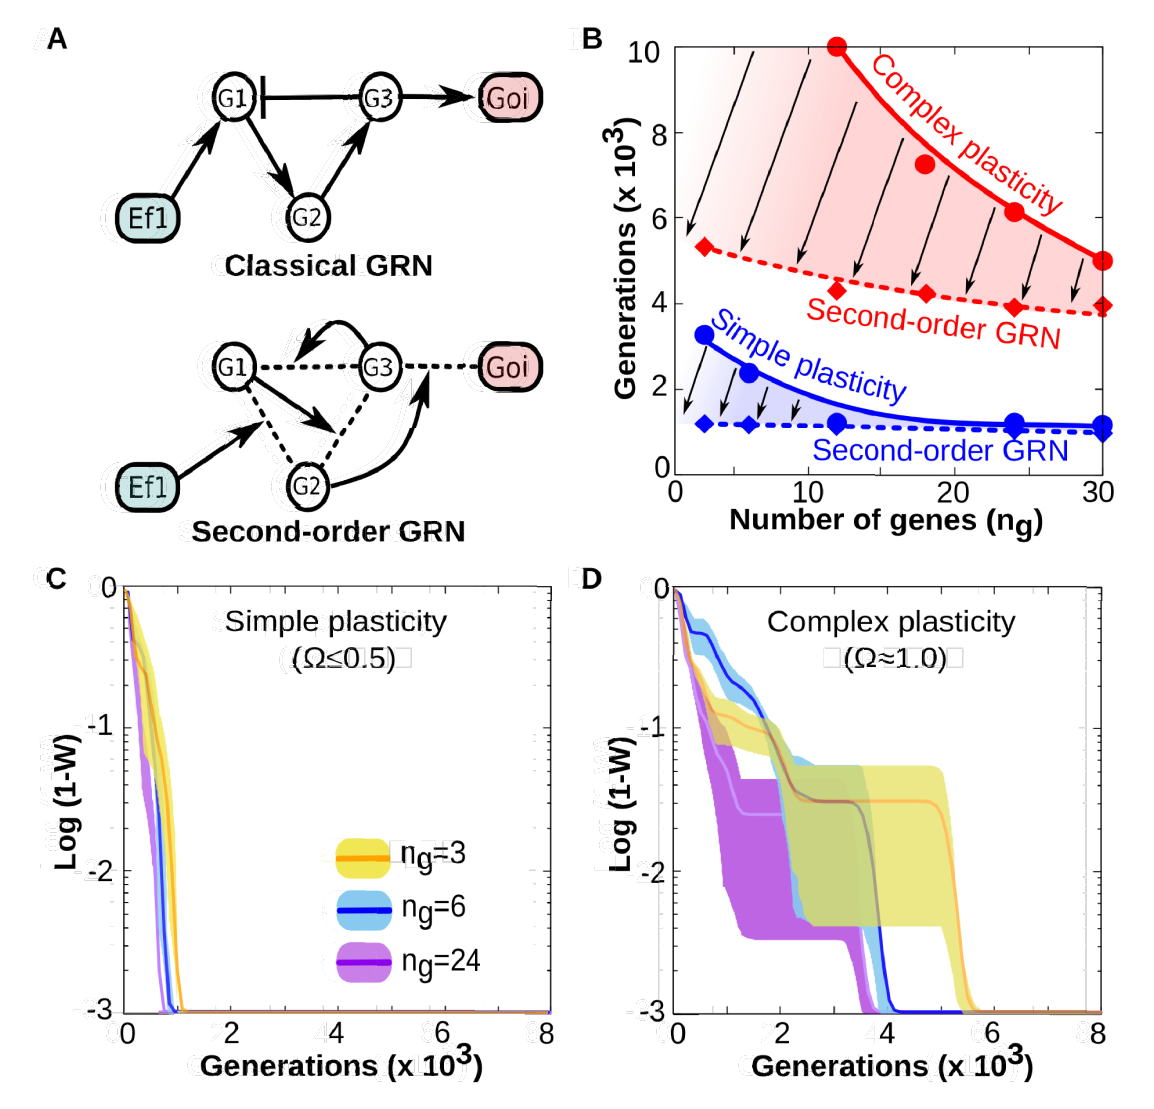
Fig 3. Second-order implementation of cell plasticity enhances evolvability. A) Contrary to “classical” GRNs in which the network topology remains fixed over developmental time, second -order (tensor-based) GRNs have dynamical topology: each gene-gene interaction strength is determined by the concentration of other genes ( g , g , etc) and environmental factors. In both cases the final phenotype is recorded as the binary 1 2 state of a gene of interest ( goi ). B) Comparison between “classical” and “second-order” GRNs in terms of their evolvability (how many generations they need to achieve a fitness W � 0 . 95 when they are selected to represent specific reaction norms). The panel shows that everything else being equal (number of genes, function complexity), GRNs with dynamical topologies (dashed smoothed lines) require much less generations to evolve any reaction norm than classical GRNs (solid smoothed lines). Thus, GRNs capable of second-order dynamics exhibit higher evolvability than classic GRNs (being the difference more patent for complex forms of plasticity). C-D) As in the classical implementation, evolving a specific form of cell plasticity is faster when the size of the GRN is large, although this relationship is much more linear (compare with Fig 2C and 2D) Ne = 3 and 30 replicates for all panels. Each replicate has the same initial conditions (an “empty network” with B , 8 i , j 2 [1, ij = 0 Ng ]) but traces a different evolutionary trajectory (different mutations). For each replicate, the target function is randomly drawn from the set of possible functions with the same Ne and O